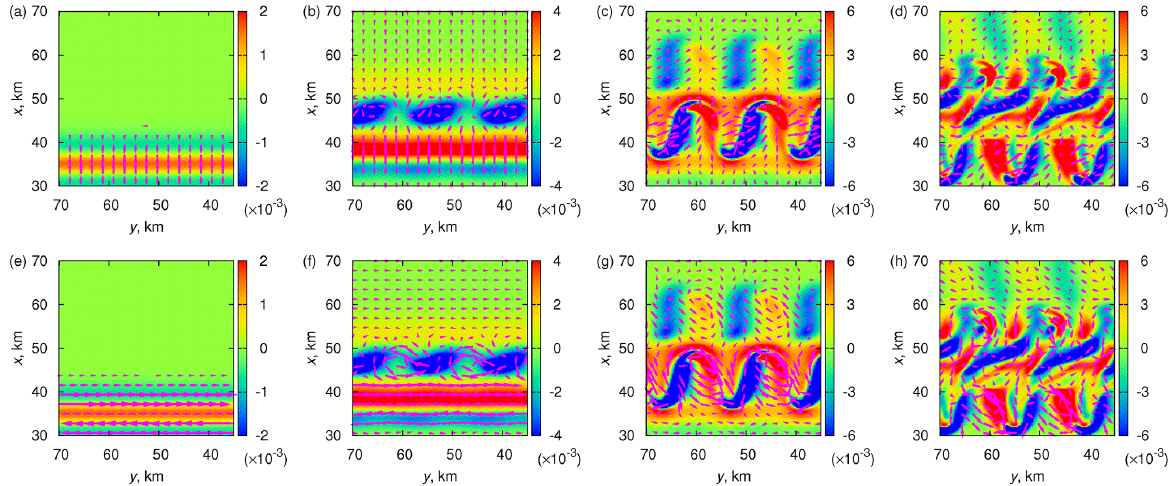
Figure 4. Same plots as Fig. 3 for j (cid:107) except that vectors shown are (a – d) Pedersen current j P and (e – h) Hall current at s = 0. The maximum amplitudes are max ( | j P | , | j H | ) = ( 2 . 1 × 10 − 3 , 4 . 3 × 10 − 3 ) , (5 . 1 × 10 − 2 , 0.10), (0.12, 0.25), and (0.17, 0.34) in Am − 1 , respectively, for t/τ A = 0 . 1–7.